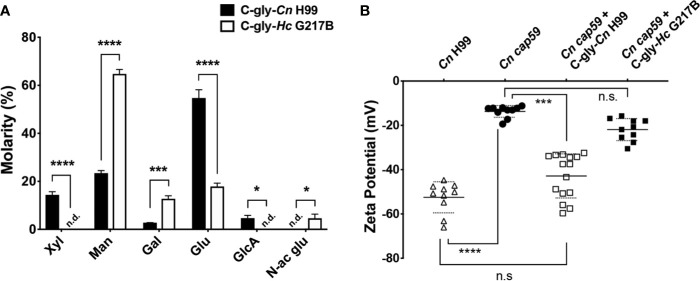
Cellular-attached glycans of C. neoformans (Cn) and H. capsulatum (Hc) had distinct glycosyl composition. (A) Molarity percentage of the monosaccharide blocks detected by GC-MS analysis, displaying a distinct composition with comparing the C-gly-Cn H99 and C-gly-Hc G217B. Notably, no glucuronic acid was found in C-gly-Hc G217B, which could influence charge. Xyl, xylose; Man, mannose; Gal, Galactose; Glu, glucose; GlcA, Glucuronic acid; N-ac glu, N-acetyl glucosamine. n.d., not detected (*p < 0.05, ***p < 0.001, and ****p < 0.0001). (B) Zeta potential experiments were used to measure the overall charge of cap59 C. neoformans yeast. Incorporation of C-gly-Cn H99 to Cn cap59 significantly increased the magnitude of the negative charge, whereas the addition of C-gly-Hc G217B had a limited effect on the charge (***p = 0.007; ****p < 0.0001).